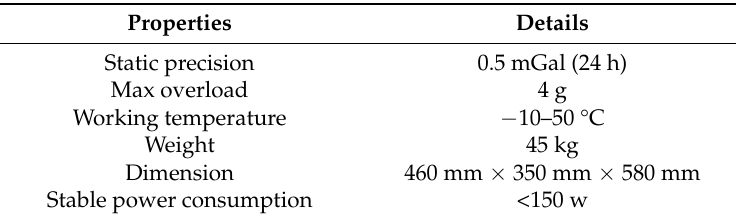
Table 1. Properties of